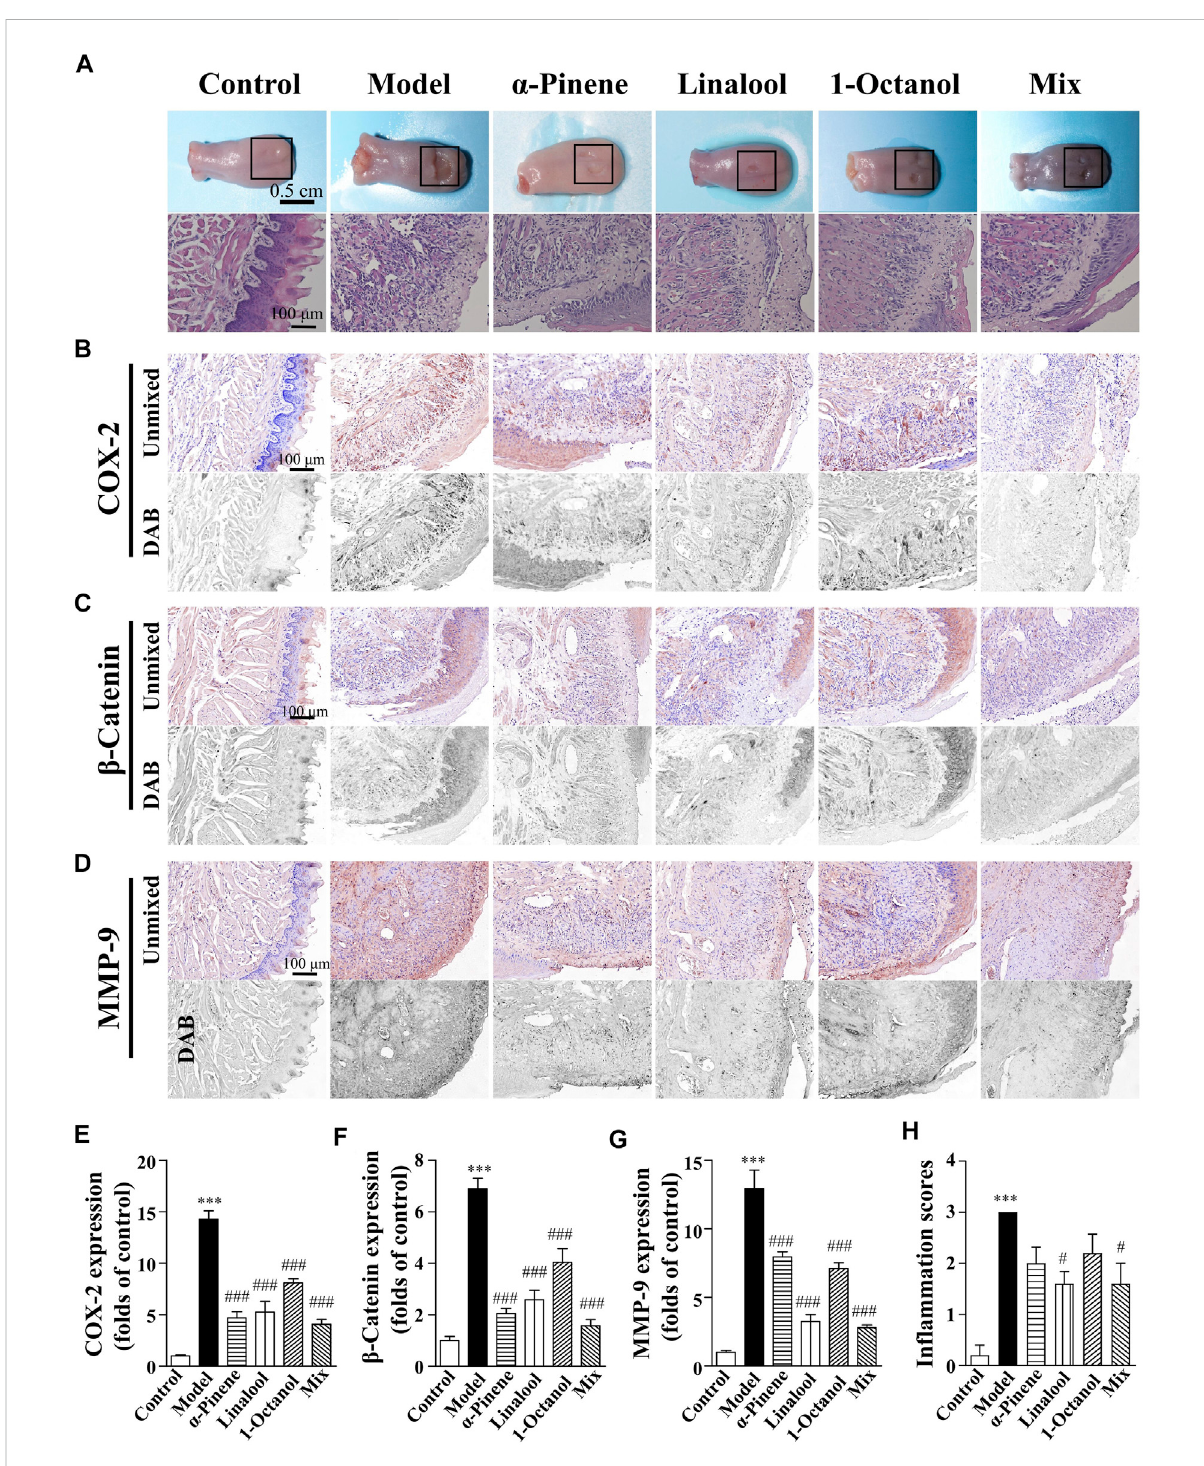
FIGURE 5 Woundhealingaccelerationof α -pinene,linalooland1-octanolforsodiumhydroxide-causedoralburnsinmice. (A) Generalviewofthetongue samples, and H&E staining of tongue sections in control, model, ShengFu oil (SFO), dexamethasone (DEX) and sesame oil (SO) groups, respectively. Representative (B – D) and summary (E – G) of histochemistry analysis of expression of COX-2, β -catenin and MMP-9, respectively. (H) The in fl ammation scores of the tongue samples in the H&E-stained images. Scale bar, 100 µm. Compared with the control group, ppp , p < 0.001. Compared with the model group, #, p < 0.05, ###, p <